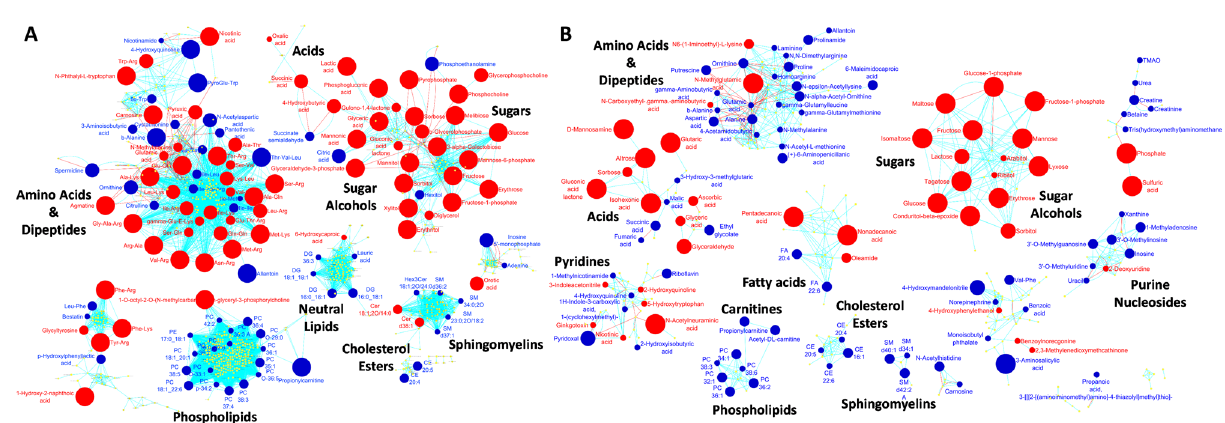
Figure 1. Chemical similarity enrichment analysis of metabolomic data highlighting the differential metabolic regulation in the intracellular medium ( A ) and extracellular medium ( B ) after incubation of HK-2 cells in HG (25 mM glucose)-hypoxia (1% O 2 ) compared to control (5.5 mM glucose/18.6% O 2 ) conditions for 48 h. Statistical enrichment analysis utilized chemical similarity and ontology mapping to generate metabolite clusters. The y-axis shows most significantly altered clusters on top, x-axis shows XlogP values of metabolite clusters. Cluster colors give the proportion of increased or decreased compounds (red = increased, blue = decreased) in each cluster. Chemical enrichment statistics is calculated by Kolmogorov–Smirnov test. Only enrichment clusters are shown that are significantly different at p < 0.05. Plots and calculations were done using ChemRICH.